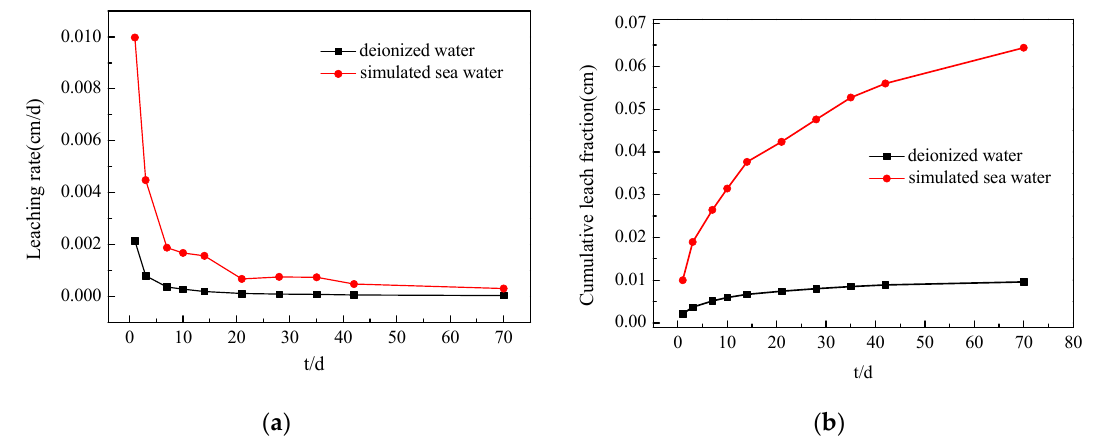
Figure 9. Leaching rate ( a ) and cumulative leach fraction ( b ) of the M–S–H cement-solidified body under different leaching fluids.